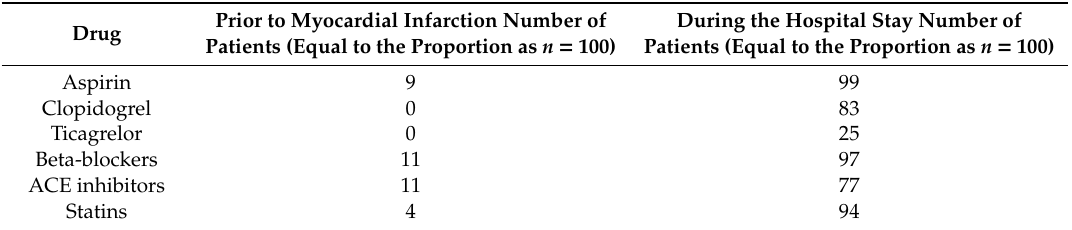
Table 2. The list of medications used in patients with ST-segment elevation myocardial infarction with preserved ejection fraction (HFpEF).